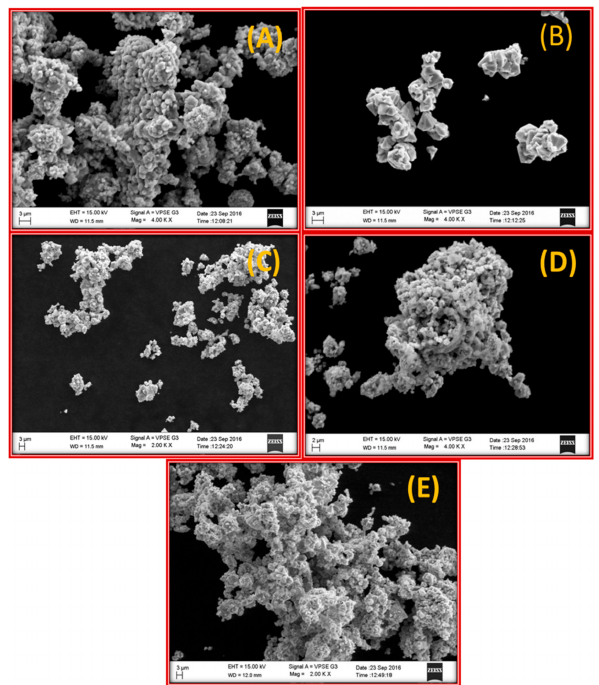
Figure 4. SEM micrograph ofZnO-NPs obtained using various concentration of C. verum plant extract ( A ) ZnO(a); ( B ) ZnO(b); ( C ) ZnO(c); ( D ) ZnO(d); ( E )